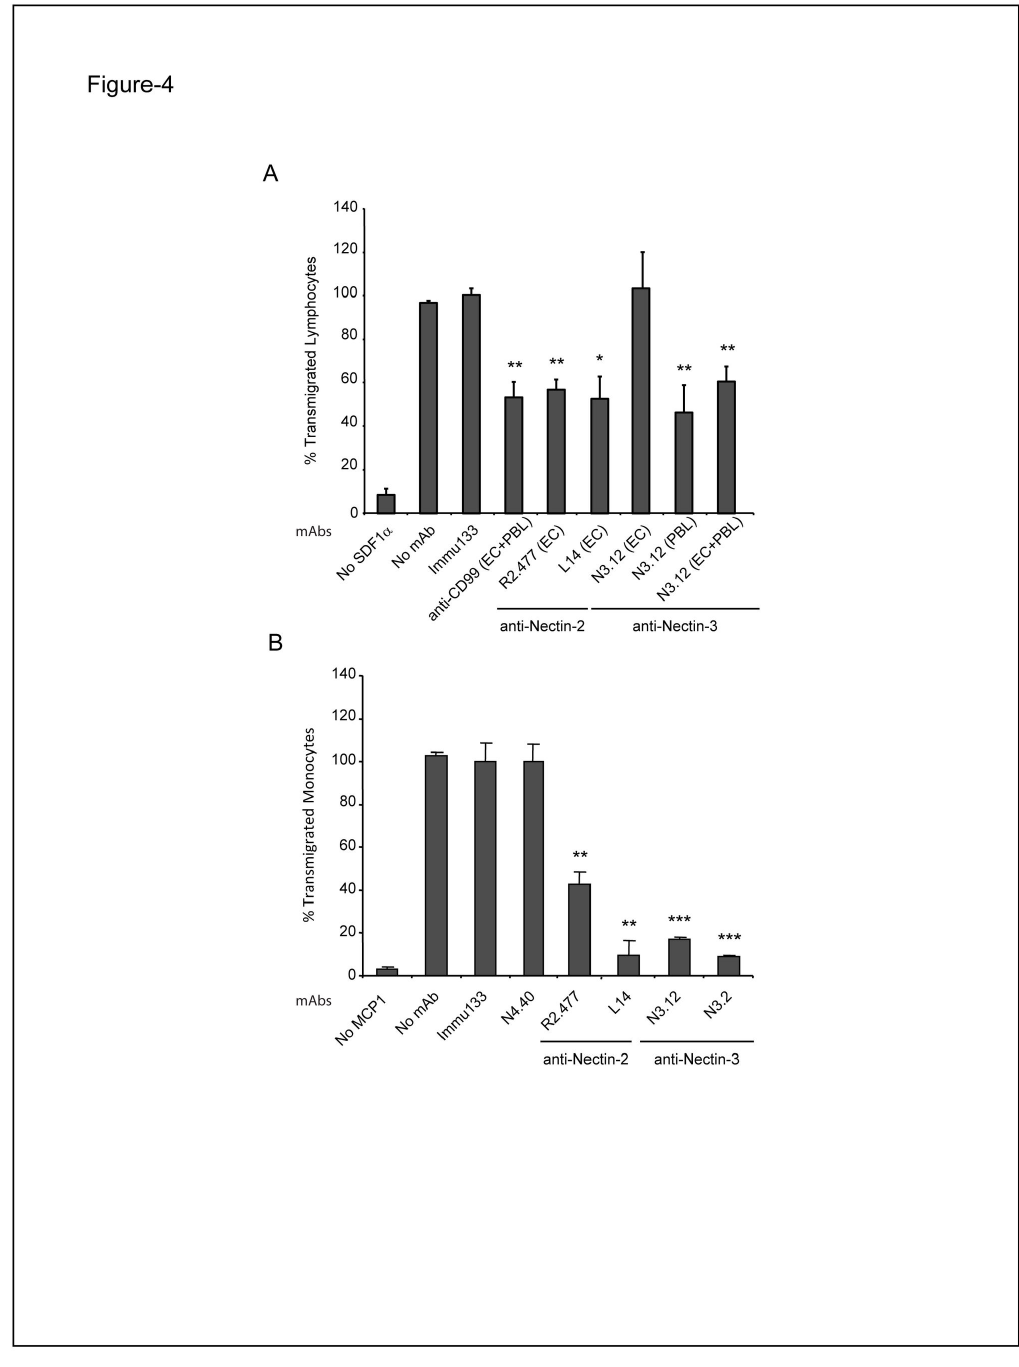
Figure 4. Nectin-2 interacts with Nectin-3 during lymphocyte transmigration. A : Lymphocyte transmigration through HUVEC monolayers was performed in the presence of anti-Nectin-2 (R2.477 or L14) blocking mAbs on ECs only, anti-Nectin-3 (N3.12) blocking mAbs on ECs only (EC), lymphocytes only (PBLs) or ECs and lymphocytes (ECs + PBLs). Anti-CD99 blocking mAbs were used as a positive control [35]. B : Monocyte transmigration was performed in the presence of anti-Nectin-2 (R2.477 or L.14) or anti- Nectin-3 (N3.12 or N3.2) blocking mAbs. In all experiments, either anti-Nectin-4 (N4.40) or anti-CD34 (Immu133) mAbs were used as isotype matched irrelevant antibodies. The value 100% corresponds to the number of lymphocytes or lymphocytes that transmigrate in the presence of the anti-CD34 mAbs. Each measurement was performed in triplicate. The results were obtained from three independent experiments. Values are mean ± SEM (error bars; N≥3); ***, P < 0.001; **, P < 0.01; *, P < 0.05. doi: 10.1371/journal.pone.0077424.g004 PLOS ONE |